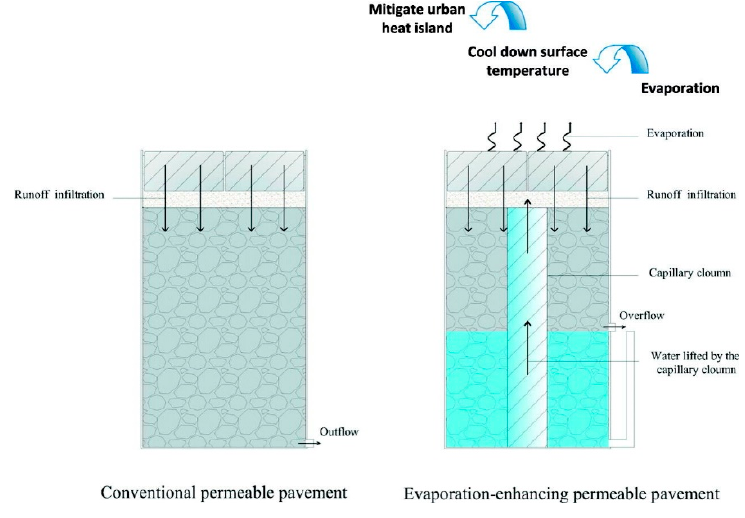
Figure 14. Figuline pavements mechanism [131].